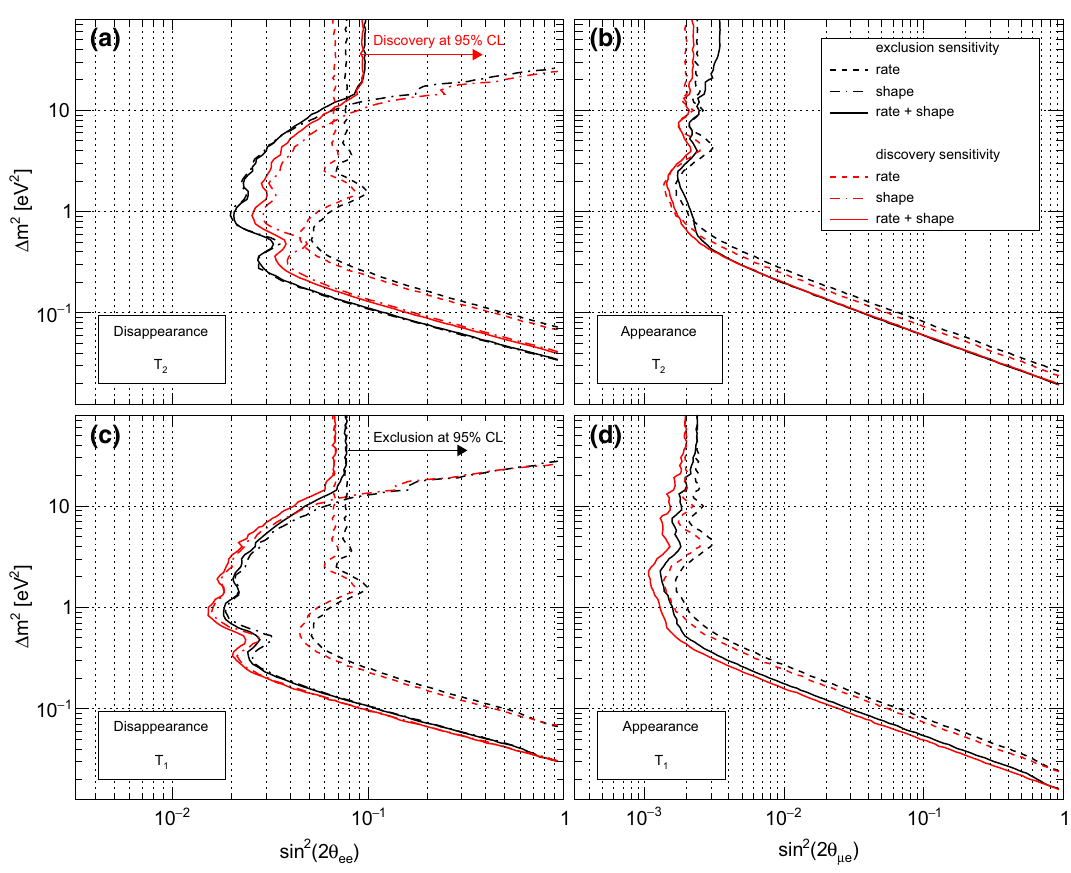
Fig. 2 Exclusion and discovery sensitivity at 95% CL for a toy disap- pearance and appearance experiment. The sensitivities are shown for the test statistics T 2 and T 1 . Whenever possible, the contribution of the shape and rate analysis are displayed separately. The discovery sensi-